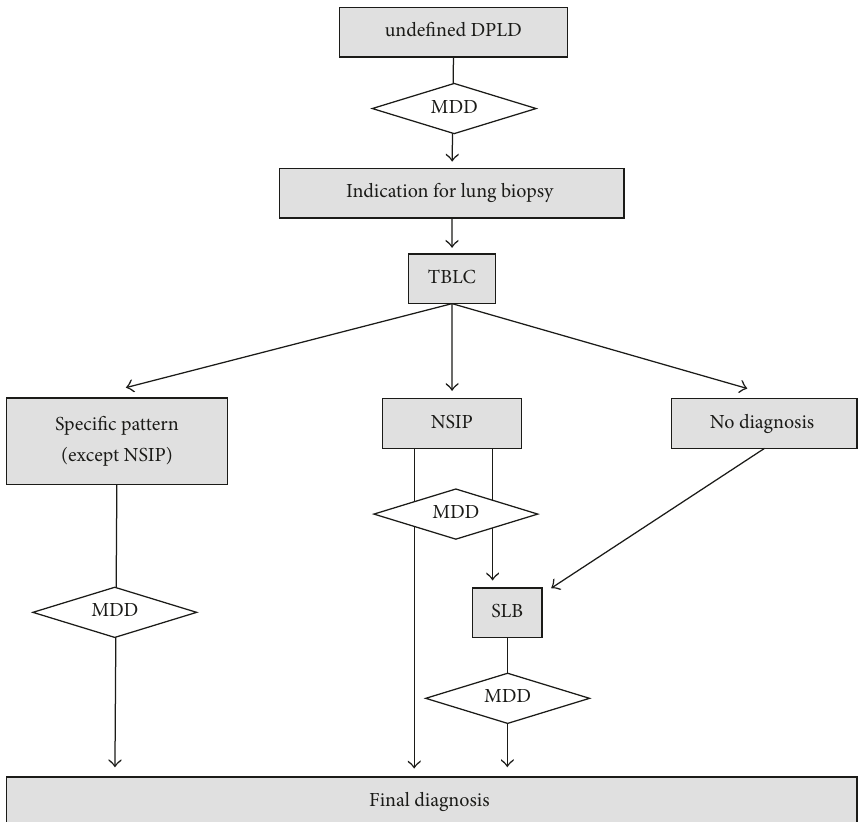
Figure 1: Algorithm summarizing the study protocol. DPLD: diffuse parenchymal lung disease; MDD: multidisciplinary discussion; SLB: surgical lung biopsy; NSIP: nonspecific interstitial pneumonia; TBLC: transbronchial lung